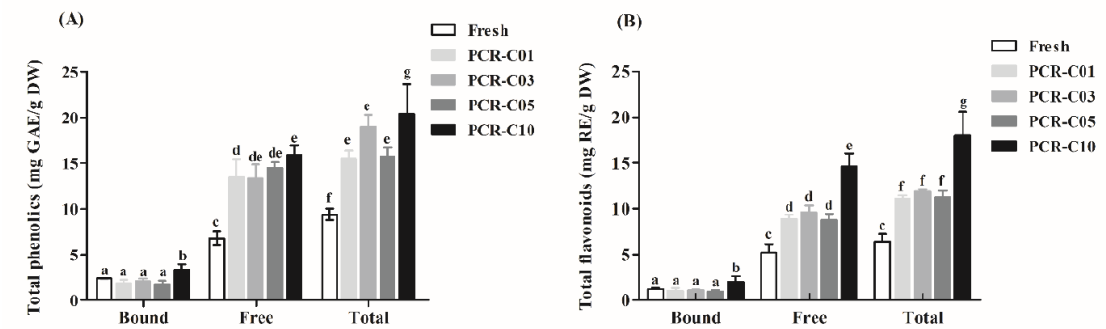
Figure 1. Free, bound, and total fraction concentrations in ( A ) total phenolics and ( B ) total flavonoids of PCR-C samples at different storage periods. Data were expressed as the mean ± SD ( n = 3). Mean values with different letters in the figure indicate significant differences among PCR-C of different storage periods ( p <